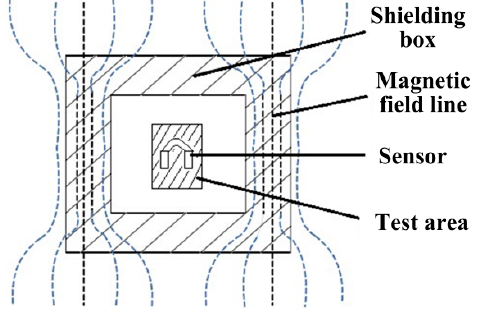
Figure 13. Principle diagram of the low frequency magnetic shield.